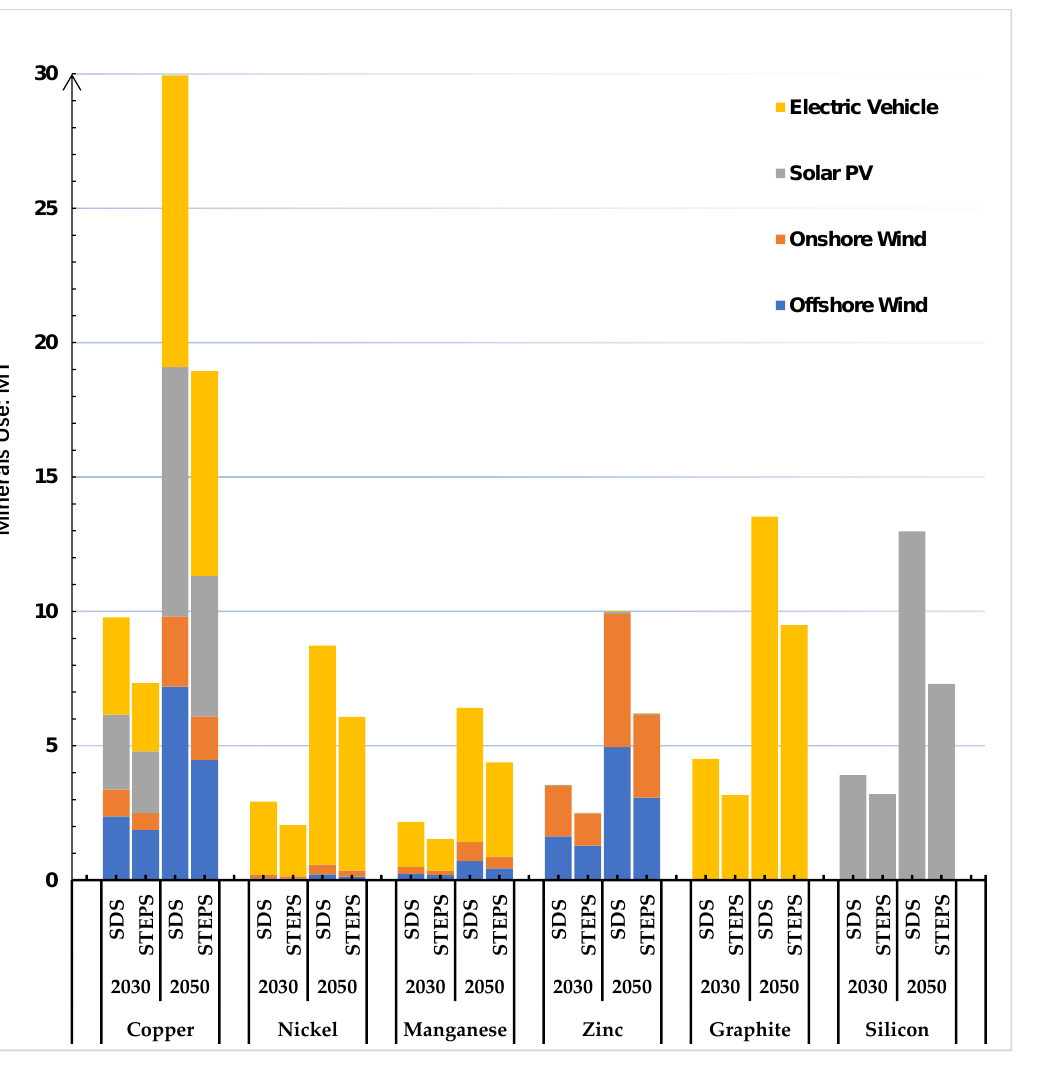
Figure 3. Clean energy technology mineral resource demand under different scenarios (1). Table 9. Cumulative installed capacity of clean energy generation technologies and electric vehicle stock (Data Source: [34]).